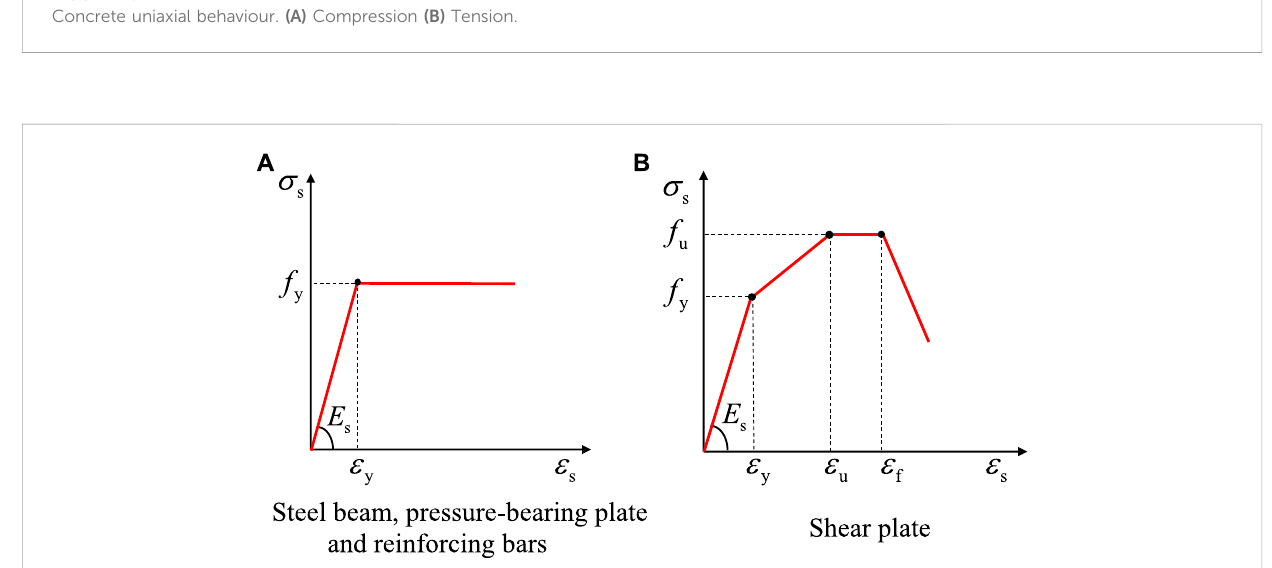
FIGURE 11 Stress-strain relationship of steel. (A) Steel beam, pressure-bearing plate and reinforcing bars (B) Shear